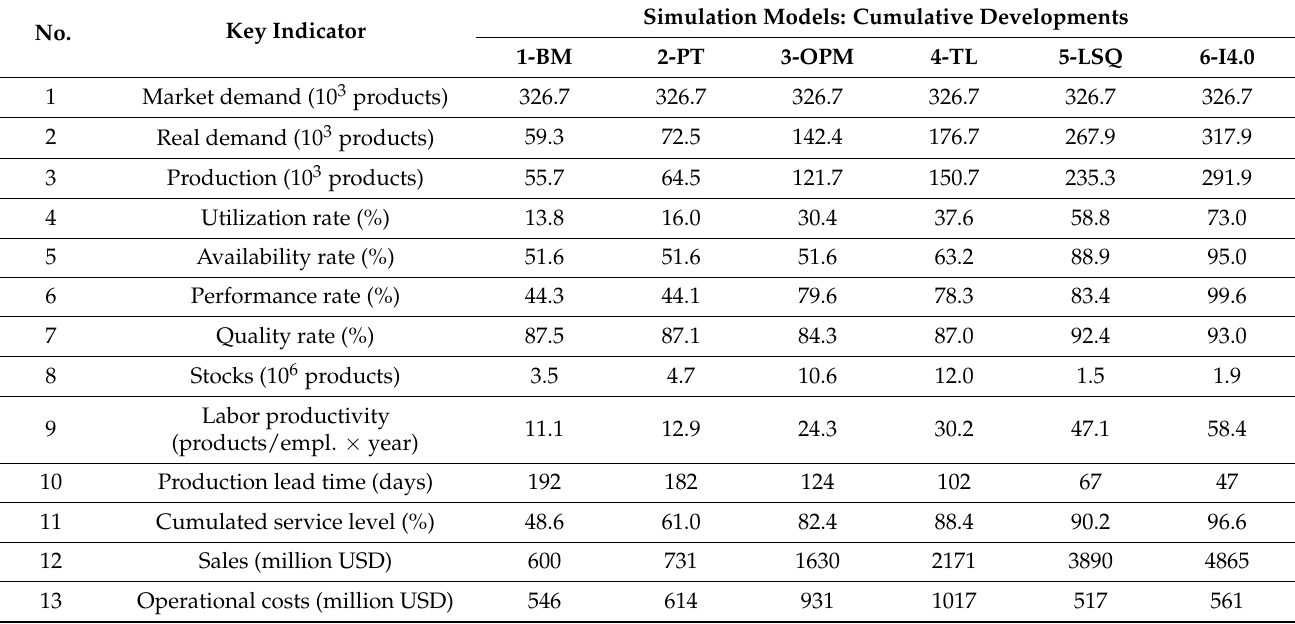
Table 2. Simulation results for the simulation models with cumulative functional developments.